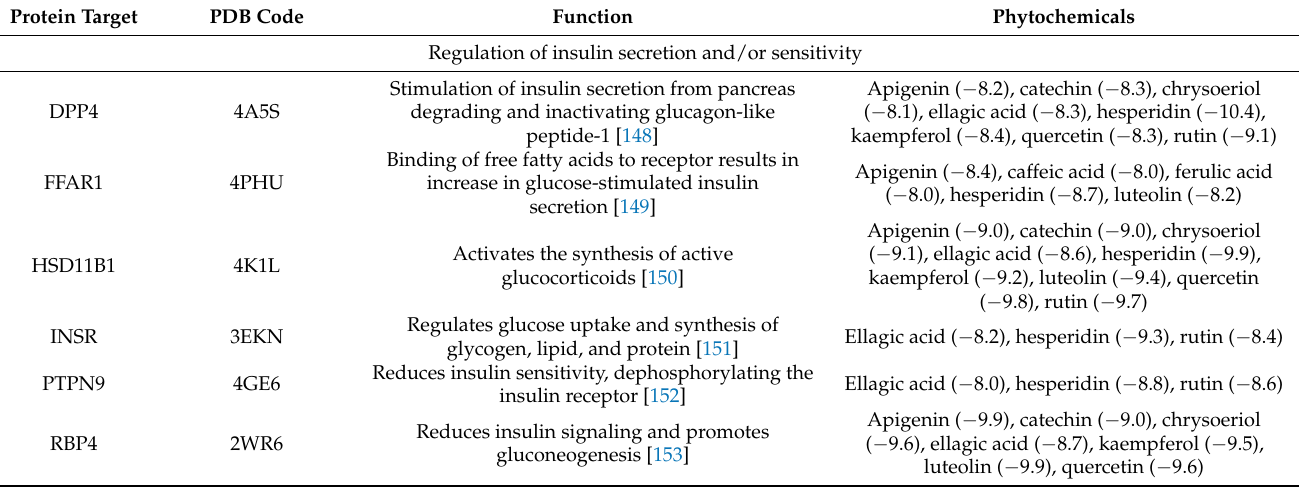
Figure 1. Structures of the studied phytochemicals present in Mediterranean plants. Table 3. The docking cut-off score of active phytochemicals for each protein target. The score is given in parentheses and expressed as kcal mol − 1